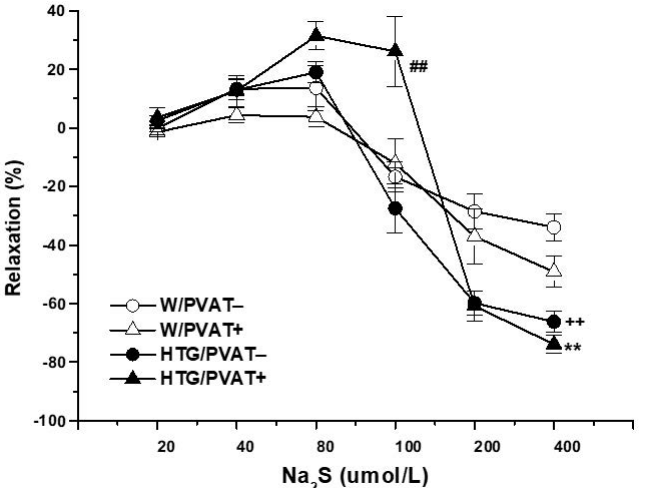
Figure 4. Dual vasoactive response of the thoracic aorta induced bysodium sulfide (Na 2 S),an exoge- nous donor of H 2 S in normotensive Wistar rats (W, n = 8) and hypertriglyceridemic rats (HTG, n = 9) with intact (PVAT+) or removed (PVAT − ) perivascular adipose tissue. The results are presented as the mean ± S.E.M., and differences between groups were analyzed by three-way ANOVA with the Bonferroni post hoc test on ranks. ** p < 0.01 vs. W/PVAT+; ++ p < 0.01 vs. W/PVAT − ; ## p < 0.01 vs. HTG/PVAT −